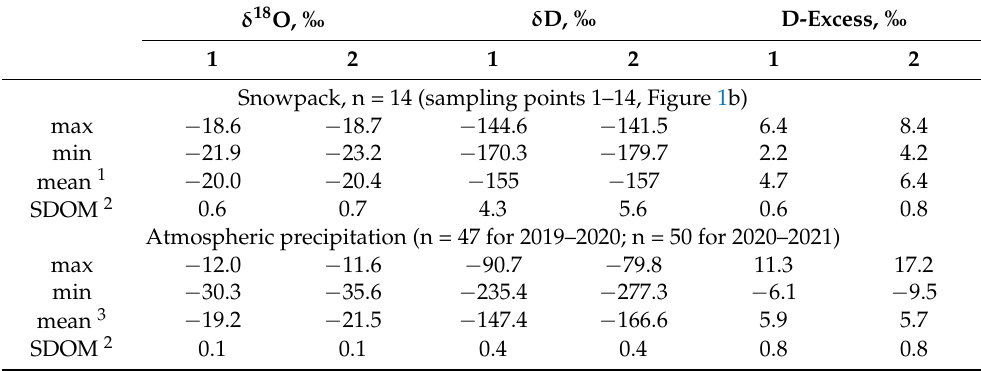
Table 1. Comparison of the isotopic composition of the bulk snowpack samples with the initial atmospheric precipitation for the winter period 2019–2020 (1) and 2020–2021 (2). δ 18 O, ‰ δ D, ‰ D-Excess,